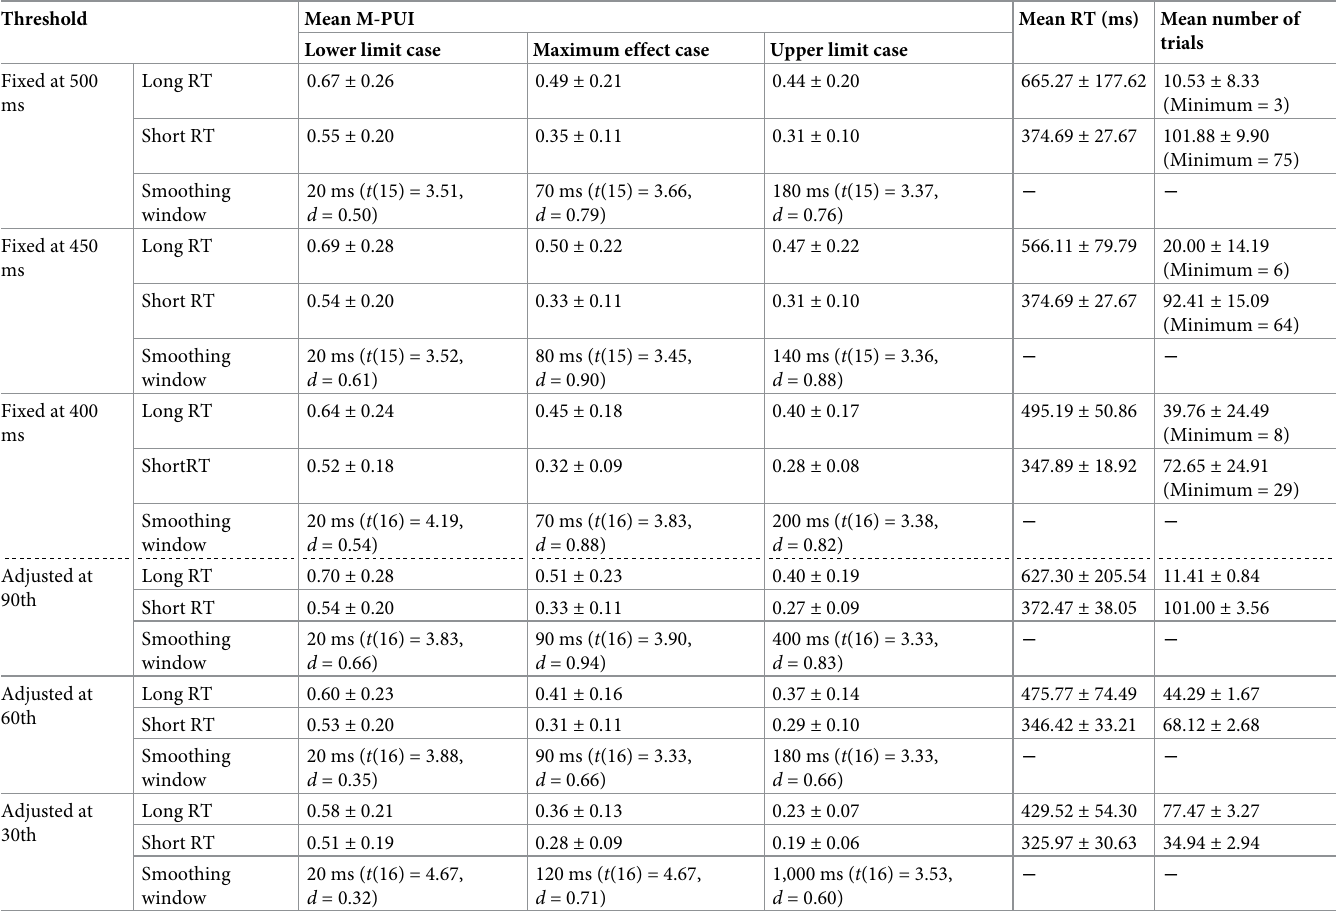
Table 1. Summary of statistics testing differences between mean M-PUIs calculated from time-series for all smoothed pupilar diameters for long and short